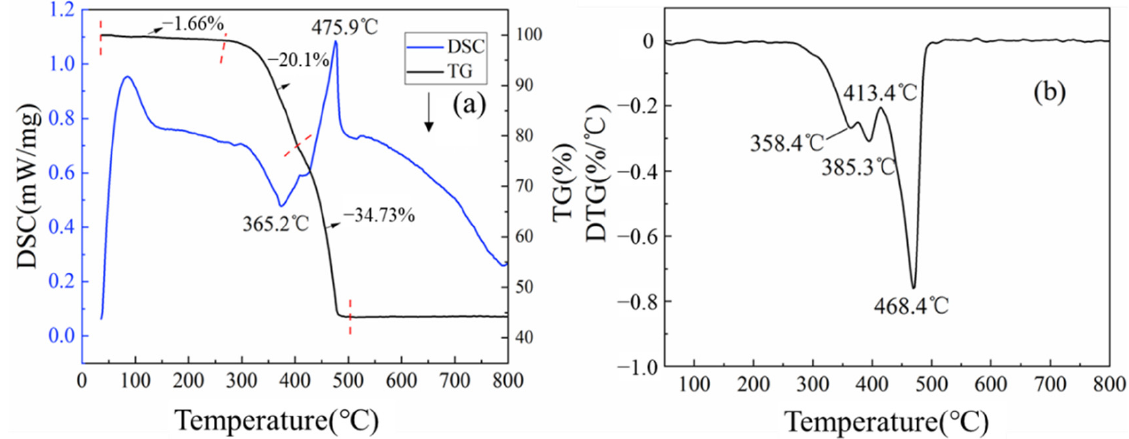
Figure 5. ( a ) TG -DSC curves of MAM; ( b ) DTG curves of MAM. It can be seen from Figure 5a that DSC curves of MAM with two endothermic peaks and one exothermic peak at temperature range is from 30 ◦ C to 500 ◦ C. The first endother- mic peak (<100 ◦ C) can be attributed to the evaporation of free water and crystal water